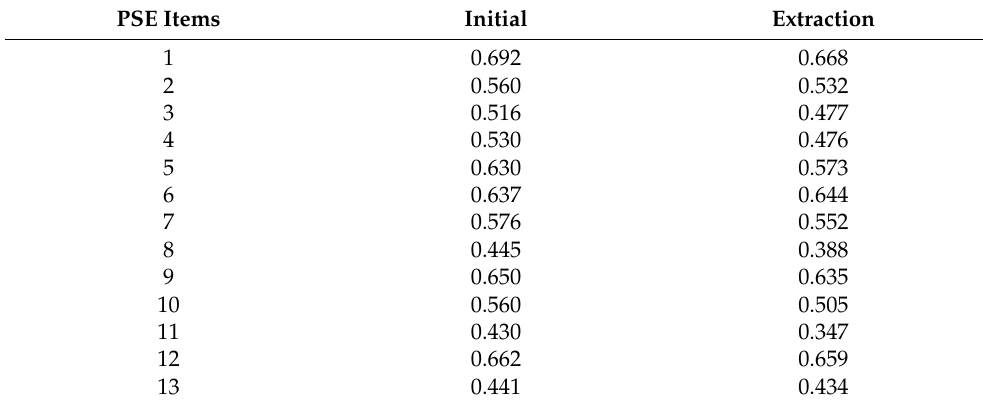
Figure 1. The sedimentation plot (scree plot). Table 2. EFA principal axis factoring communalities.